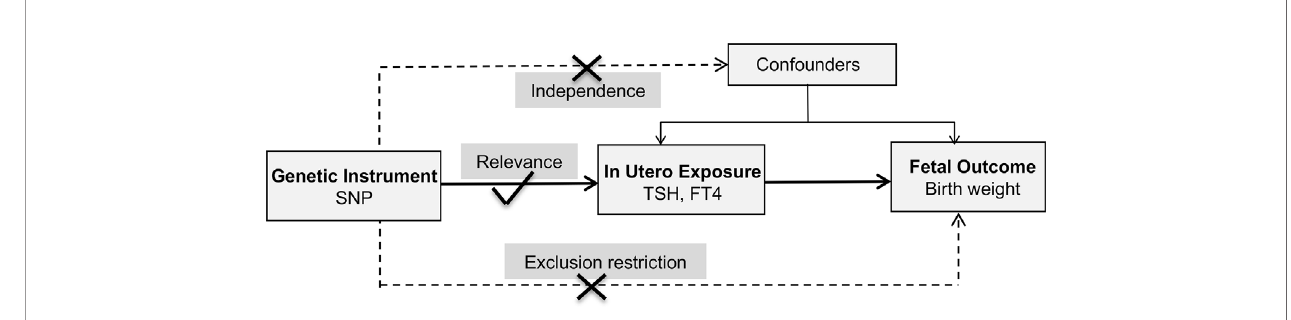
FIGURE 1 | Schematics for the Mendelian randomization study. FT4, free thyroxine; SNP, single nucleotide polymorphism; TSH, thyroid stimulating